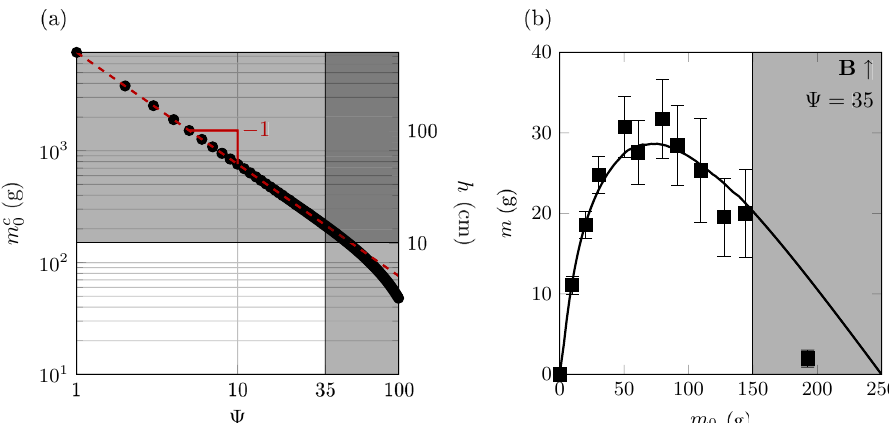
, for which the apparent mass of the packing is 0 / Ψ (cid:2) 1 , as 0